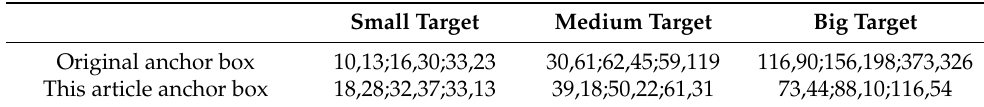
Table 2. Dataset anchor box width and height values.